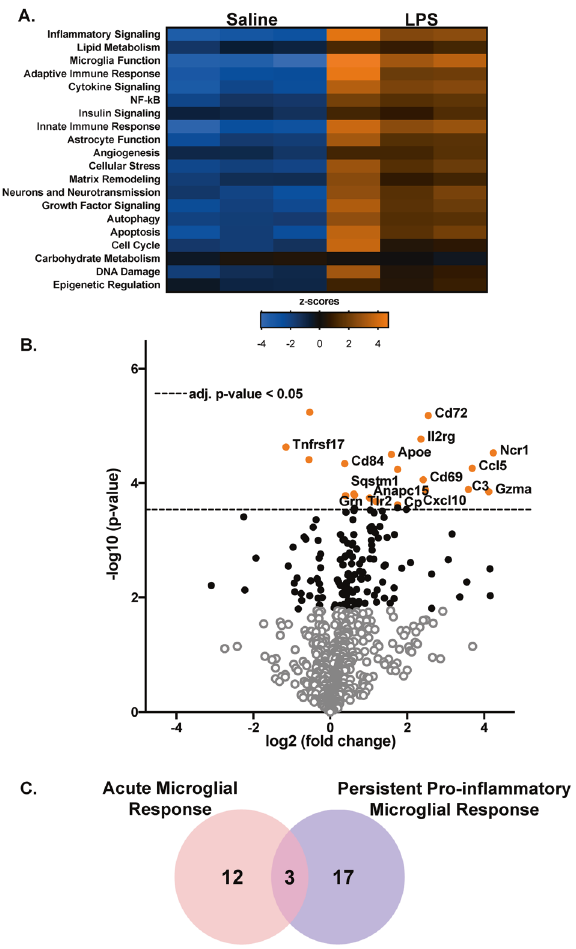
Fig. 3 The persistent pro-in fl ammatory microglia (PPM) tran- scriptome. Male C57BL/6 mice received a single IP injection of LPS or saline and microglia were isolated from whole brains at 7 days later. The nanoString Mouse Neuroin fl ammation Panel was used to determine differential mRNA expression. ( A ) Hierarchical clustering of the differentially expressed genes was assessed and signi fi cantly enriched biological pathways were identi fi ed by Ncounter system. A heatmap depicting the gene expression by category is depicted for the saline and LPS treatment at 7 days after administration. Orange indicates high expression; blue indicates low expression. ( B ) A volcano plots depicting the differential mRNA expression in 7 days LPS vs Saline. Values shown are the log2 (fold change) ratios of LPS treatment with respect to the saline group plotted against the − log10 ( p -value). The black dots denote the analyzed genes with p -value below the given False Discovery Rate (FDR) or p -value threshold. The horizontal line indicates the False Discovery Rate (FDR) threshold or adjusted p-value <0.05 determined by the Benjamini – Yekutieli and the orange dots indicate the most statistically signi fi cant genes ( p < 0.05). ( C ) The Venn diagram illustrates the overlap of signi fi cantly modi fi ed genes by